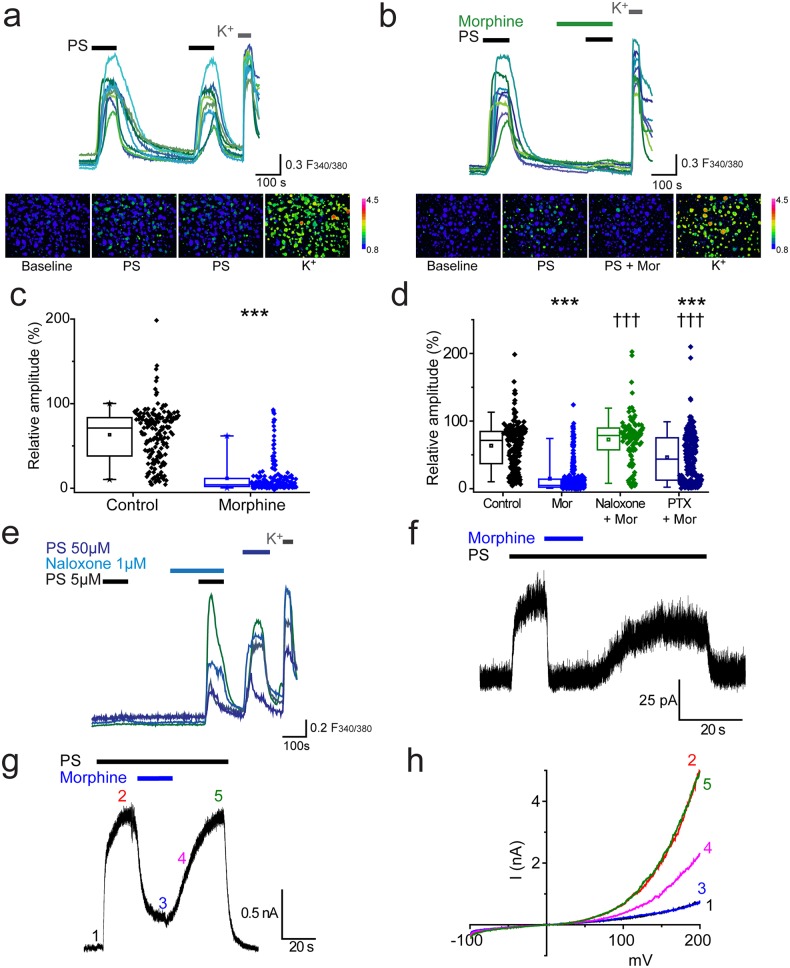
Morphine inhibits TRPM3 channels expressed on sensory neurons.(a) Traces of DRG [Ca2+]i responses evoked by two sequential PS challenges (20 µM) followed by high K+ (50 mM KCl). (b) Effect of treatment with 10 µM morphine for 2 min before and during the second PS challenge. F(340/380) indicates fura-2 emission ratio. The lower panels in (a) and (b) are pseudocolour images illustrating the change in F340/380 ratio in response to PS and KCl. The bar indicates the colours corresponding to various F340/380 values. (c) Box and whisker plots and data points showing the amplitudes for responses to the second PS challenge in (a) and (b), ***p<0.001; Mann-Whitney U test (control, n = 174; morphine, n = 209). (d) Effect of treatment with morphine (10 µM, n = 323), morphine (10 µM) and naloxone (1 µM, n = 110) and morphine (10 µM) following an incubation with pertussis toxin (200 ng/ml for 2.5 h-18h, n = 253) on [Ca2+]i responses evoked by the second PS (20 µM) challenge using the protocol in (a and b). Control group, n = 188. (e) Traces displaying neuronal [Ca2+]i responses to two PS (5 µM) challenges in the absence and presence of naloxone (1 µM), followed by a 50 µM PS challenge and high K+ (50 mM KCl). ***p<0.001, compared to control. ††† p<0.001, compared to morphine (10 µM), Kruskal-Wallis. (f) Whole cell recording illustrating that morphine reversibly inhibits PS-evoked outward membrane currents in DRG neurons (+40 mV). (g) Inhibitory effect of morphine on whole cell outward current in a CHO cell co-expressing TRPM3 and µ-opioid receptor (+60 mV). (h) Current-voltage relationships for another TRPM3/µ-opioid receptor expressing CHO cell measured at times corresponding to time points 1–5 in panel g.